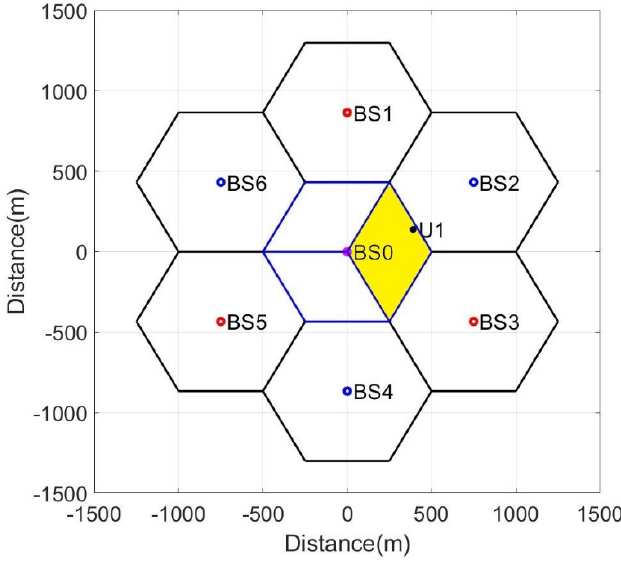
Figure 4. Layout of the coverage area of a mobile user in a hexagonal cell distribution.